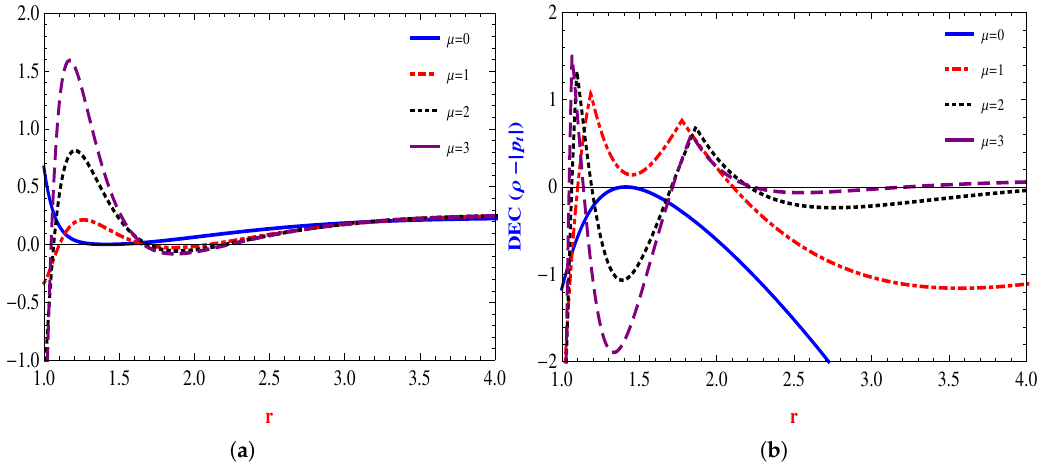
Figure 9. Plots: ( a ) Radial DEC ( ρ − | p r | ) , and ( b ) Tangential DEC ( ρ − | p t | ) with throat radius r 0 = 1, α = 1, β = 1, and γ = 2 in f ( Q ) = α Q 2 + β Q + γ